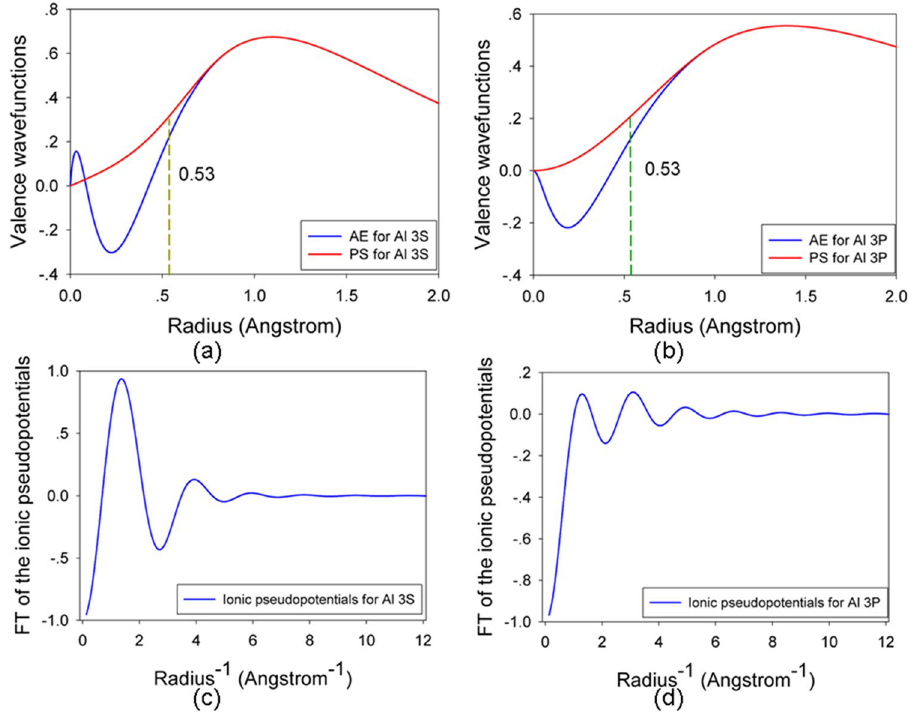
Figure 6. ( a , b ) All-electron (AE) and pseudo (PS) valence wave functions as a function of radius for aluminum 3 s and 3p orbitals; ( c , d ) Fourier transfer of the ionic pseudo potential as a function of radius -1 for aluminum 3 s and 3p orbitals.